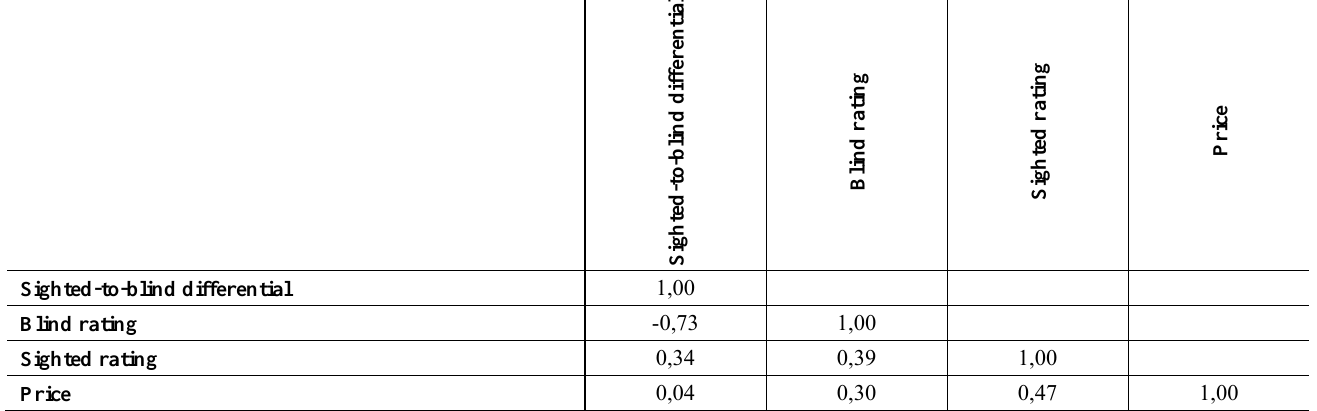
Table 8: A correlation matrix detailing the relationship between the variables across the entire dataset (n =